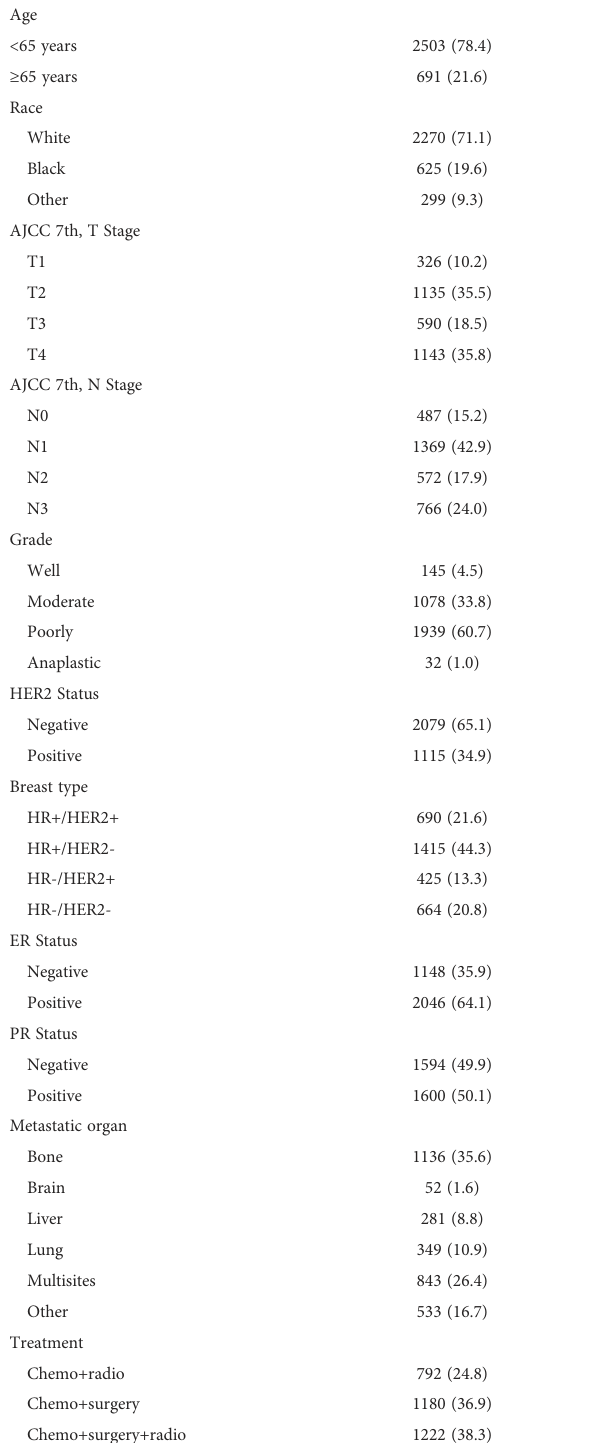
TABLE 1 Baseline and treatment